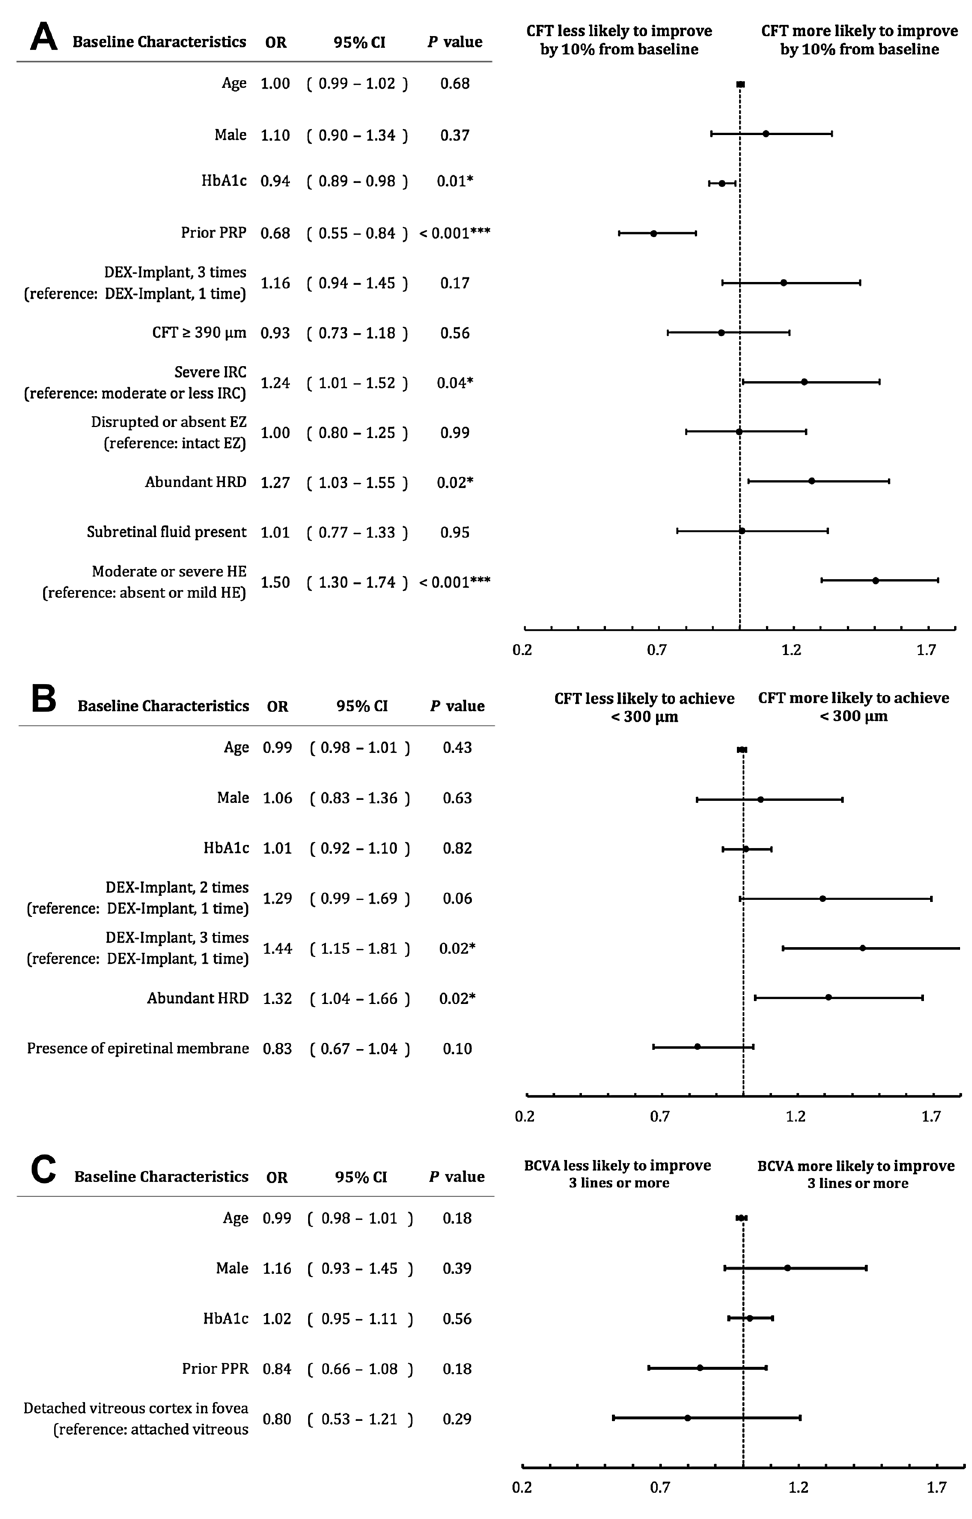
Figure 1. Multivariate analysis of imaging biomarkers and outcomes after dexamethasone (DEX) implant treatment in patients with diabetic macular edema (DME). ( A ) Endpoint 1: CFT reduction of 10% or more from baseline. ( B ) Endpoint 2: CFT < 300 µm at 6-month. ( C ) Endpoint 3: BCVA improvement of 3 lines or more from baseline. ( BCVA best-corrected visual acuity CFT central foveal thickness, CI confidence interval,